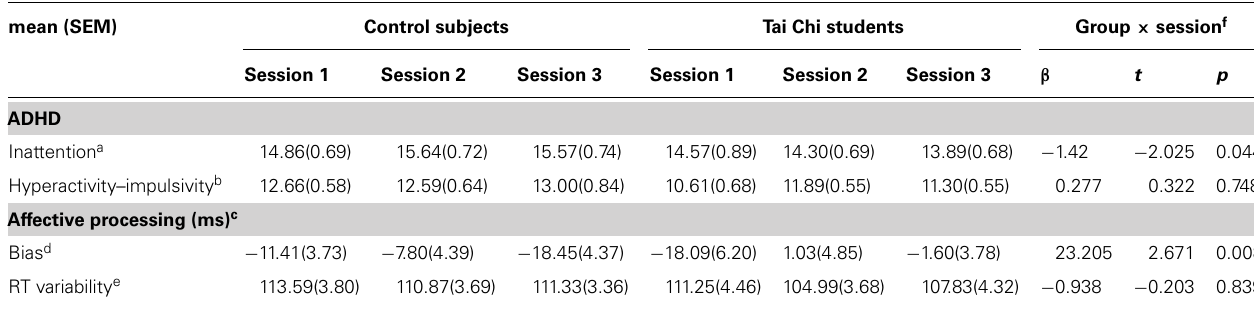
Table 4 | Effect of tai chi training –ADHD and affective